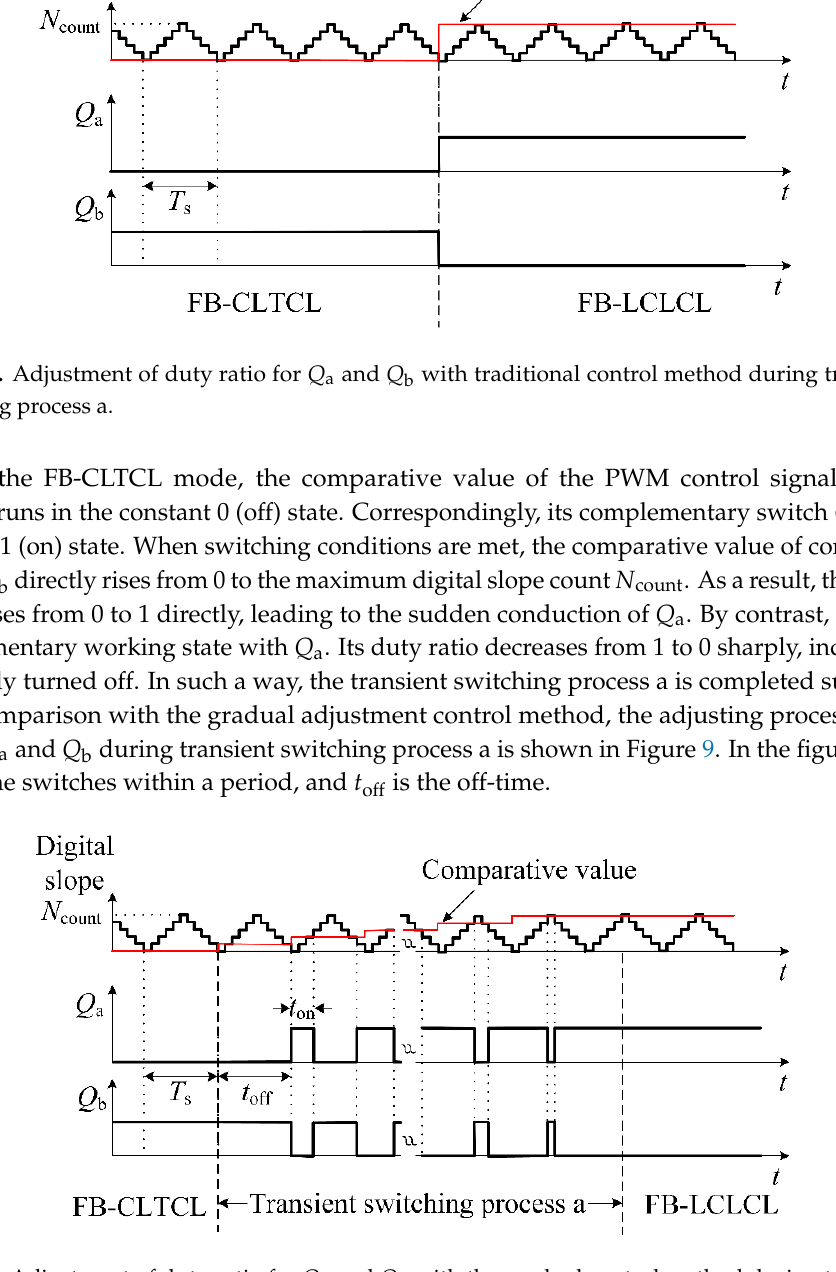
Figure 9. Adjustment of duty ratio for Q a and Q b with the gradual control method during transient switching process a.